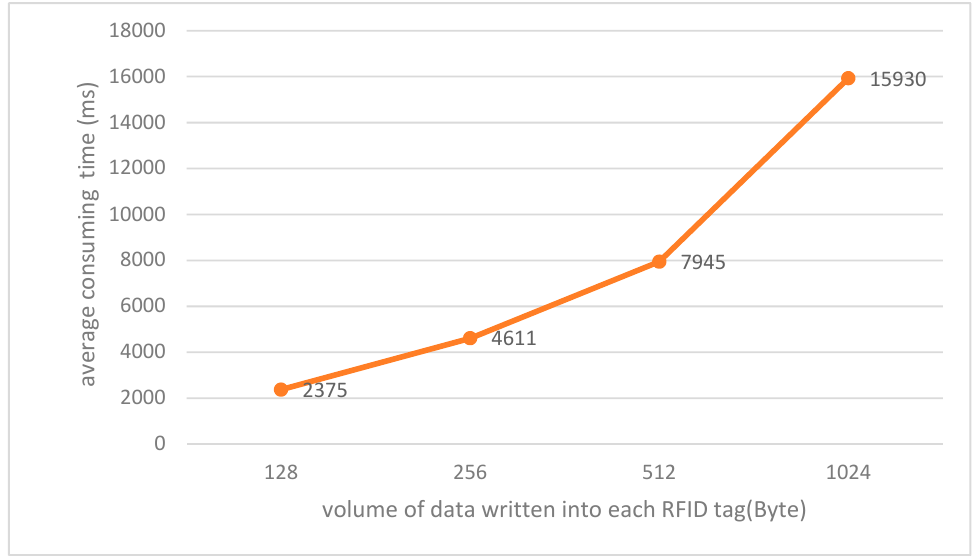
Figure 14. Average time consumed for writing different volumes of data (128 bytes, 256 bytes, 512 bytes and 1024 bytes for each tag respectively) into all 35 RFID tags simultaneously. For each volume, 5 tests were performed and the average consuming time was obtained.